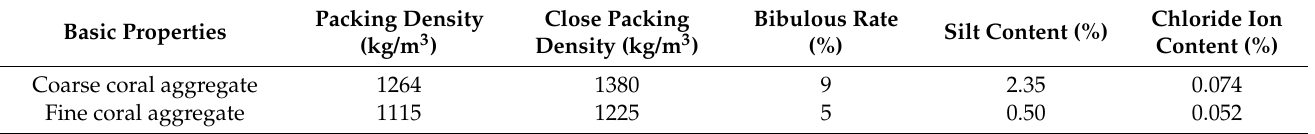
Figure 2. Particle morphology of the coral aggregates: ( a ) coarse coral aggregate and ( b ) fine coral aggregate. Table 3. Basic properties of the coarse coral aggregate and fine coral